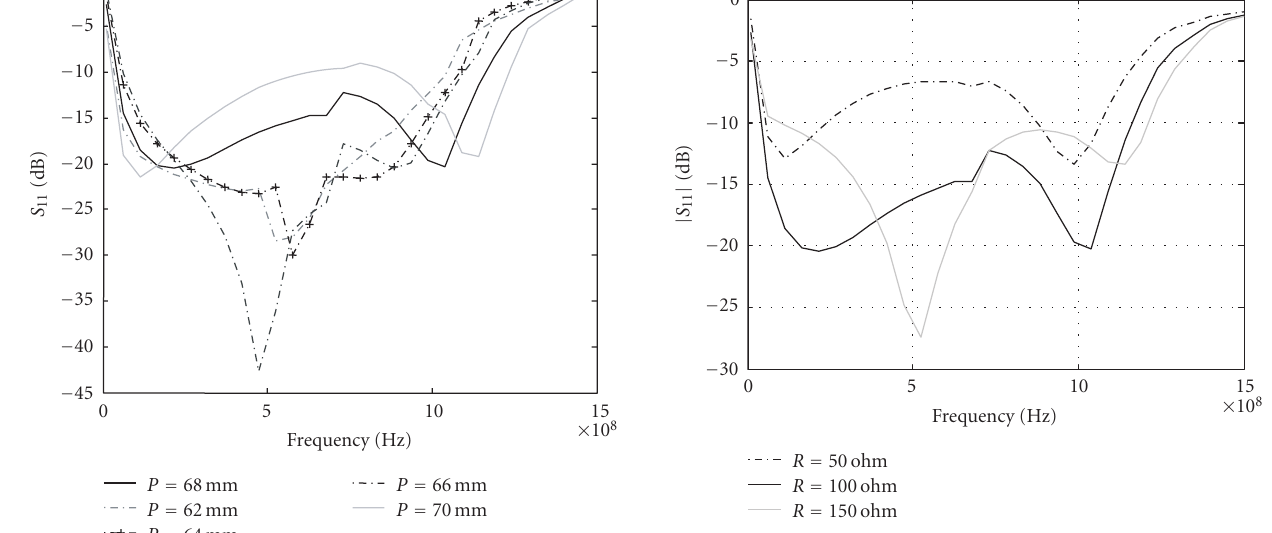
Figure 7: E ff ect of varying resistive loads value to the antenna